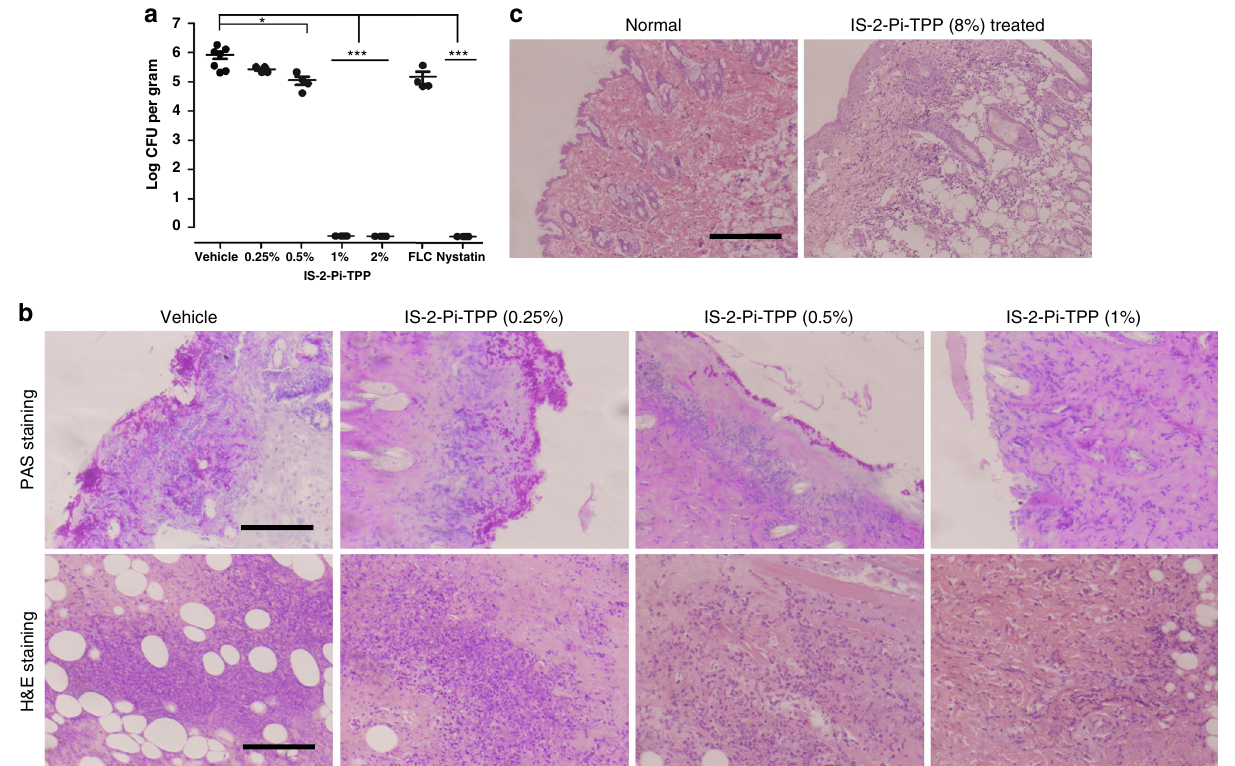
Fig. 5 Topical application of IS-2-Pi-TPP ointment to treat C. albicans murine skin infections. a Abraded murine skin was inoculated with 10 7 C. albicans SC5314 cells. After 24 h, the skin was treated with ointment containing no drug (vehicle) or 0.25%, 0.5%, 1%, or 2% (w/w) IS-2-Pi-TPP. Ointments containing 1% FLC or nystatin were used as positive controls. The fungal burden in the skin is expressed as the number of viable C. albicans cells (log 10 CFUs per gram) in 4 – 7 skin samples for each group of mice (seven mice in the vehicle control, four mice in the treated groups). Each circle represents one skin sample. The two-tailed unpaired t -test was performed. * P < 0.05, *** P < 0.001 indicate signi fi cance. b Micrographs of PAS-stained and H&E-stained skin biopsies after the indicated treatments. Scale bar, 100 μ m. c Evaluation of the skin toxicity of IS-2-Pi-TPP. Ointment containing 8% IS-2-Pi-TPP was applied on abraded murine skin. H&E staining was used to detect lymphohistiocytic in fi ltrates under IS-2-Pi-TPP treatment. Scale bar, 100 μ